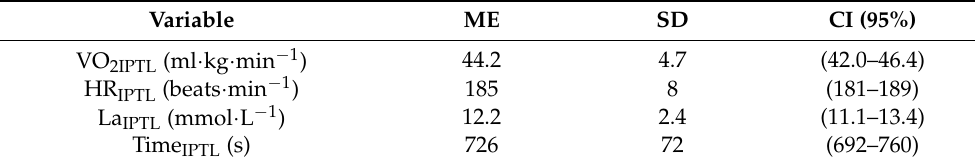
Table 2. Total descriptive data of the results obtained in the pool test (IPTL).